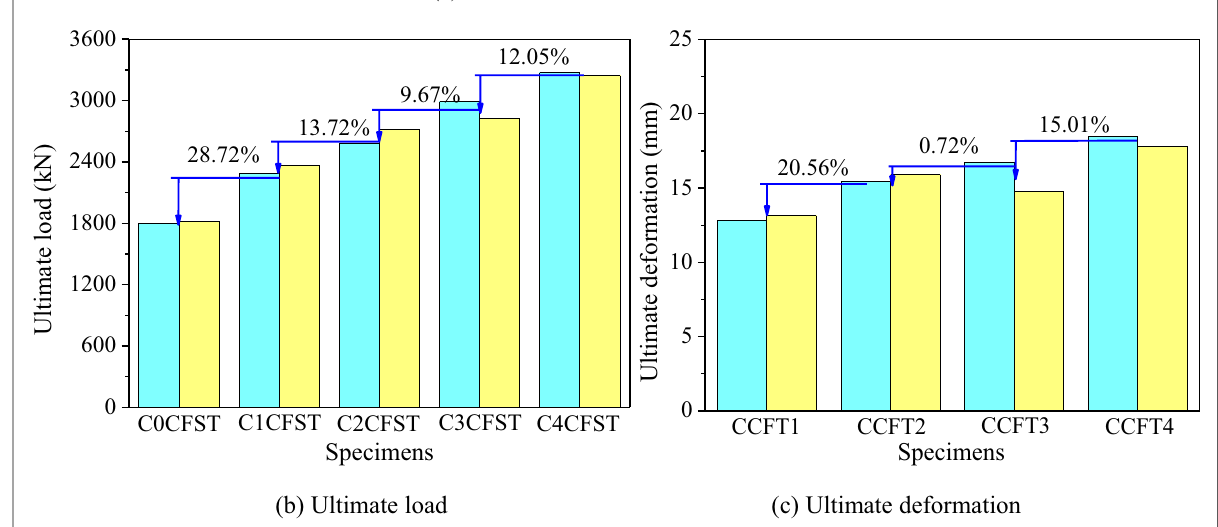
Fig. 14 Effect of layers of FRP on ultimate